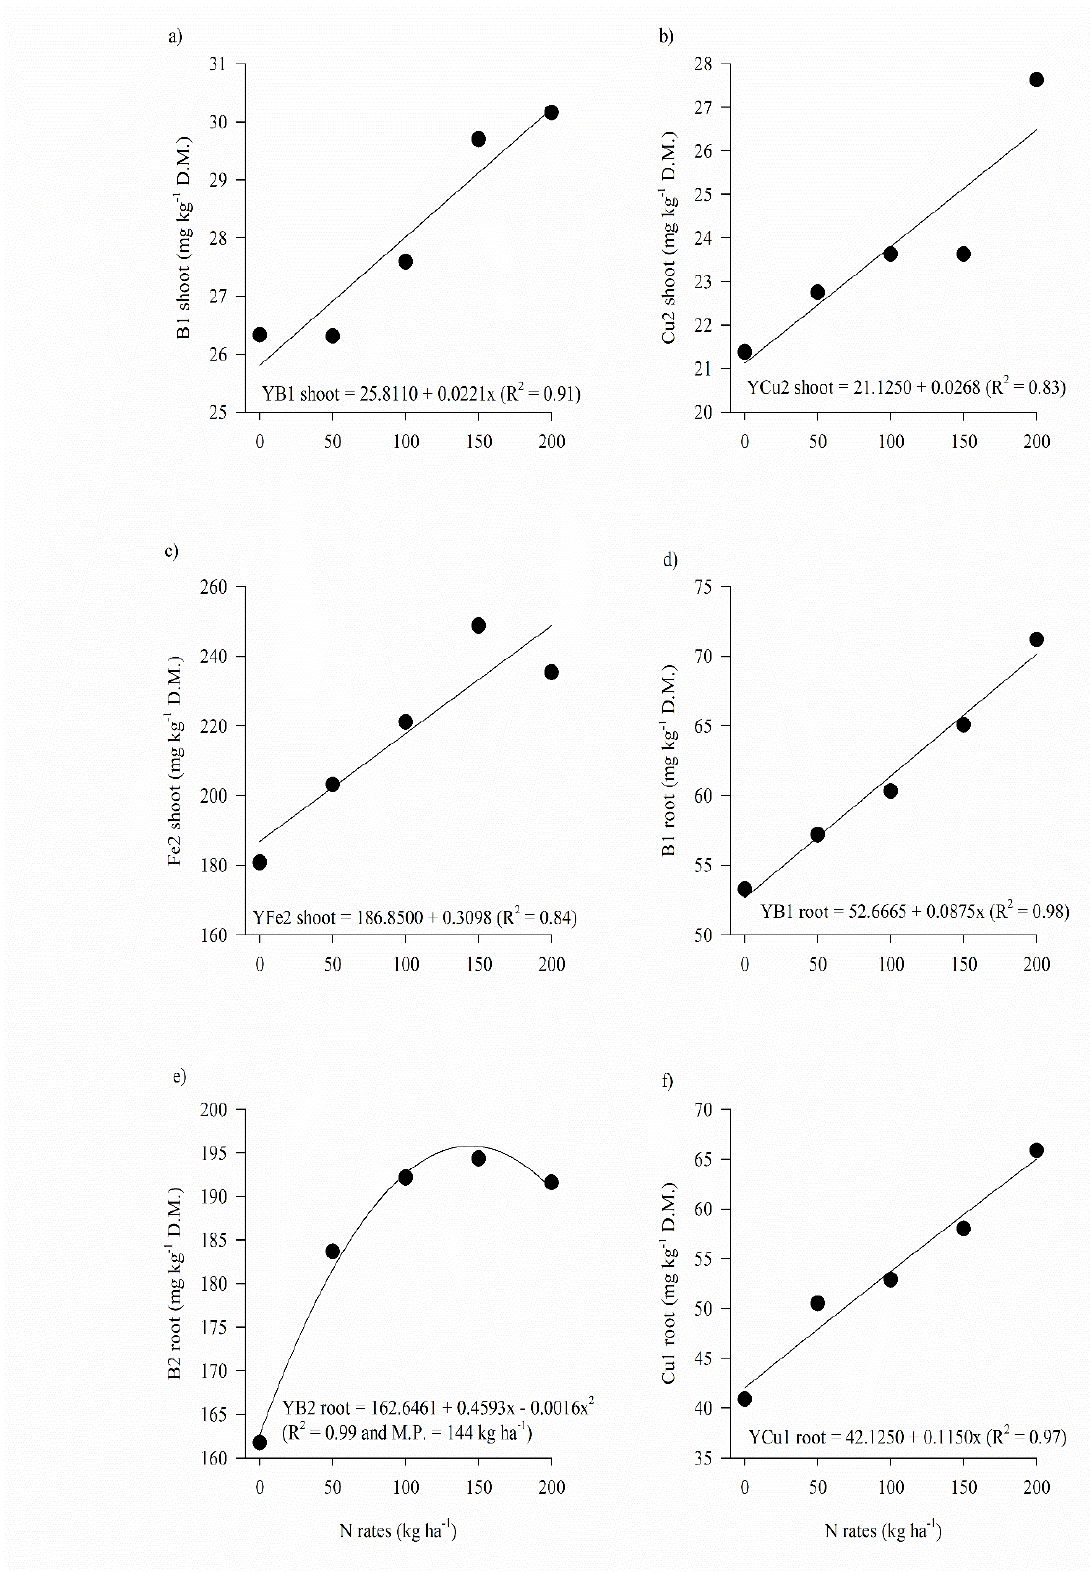
Figure 3. Effect of N rates in B (a), Cu (b) and Fe (c) concentration in shoot, and B (d and e) and Cu (f) concentration in root. Selvíria, MS – Brazil, agricultural crop 2015/2016 1 and 2016/2017